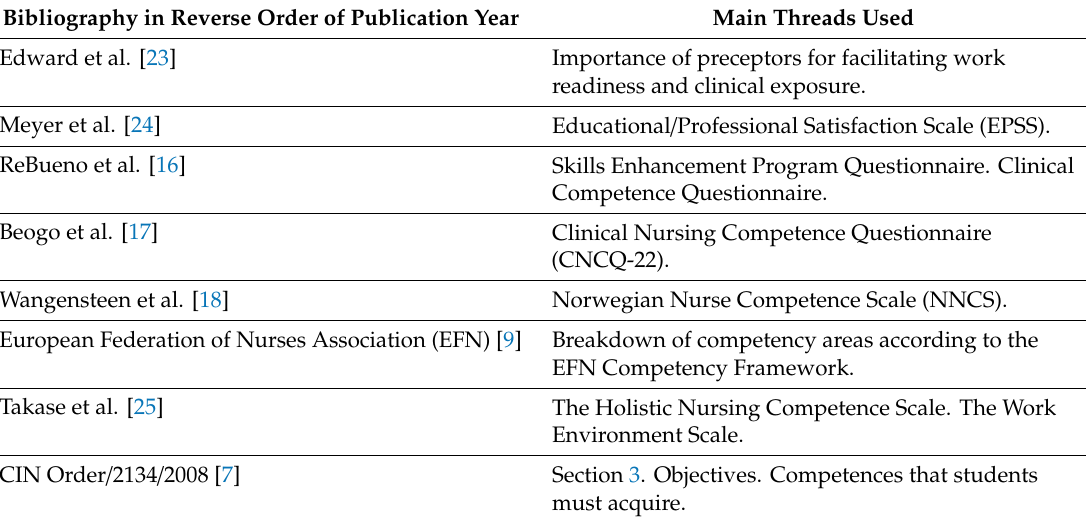
Table 1. Relevant scientific literature used as a framework for the interview guide.